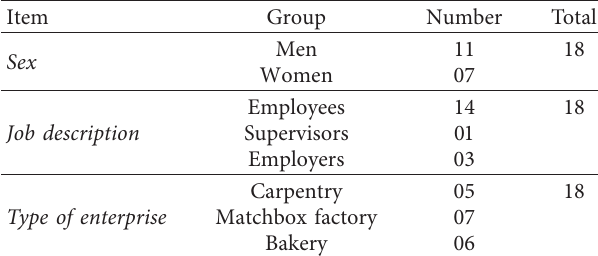
Table 1: Demographic